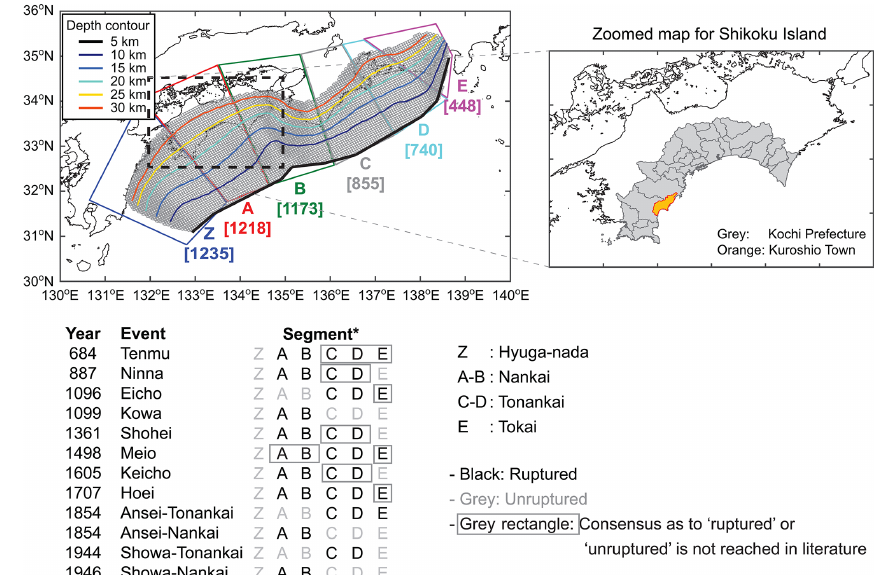
Figure 1. Nankai–Tonankai Trough source region and history of tsunamigenic megathrust ruptures. The segment boundaries Z to E are based on Garret et al. (2016). The numbers in the square brackets correspond to the numbers of sub-faults of the 2012 Central Disaster Management Council tsunami source model falling within the segments. The rupture history is based on Garret et al. (2016), Fujino et al. (2018), and Fujiwara et al.